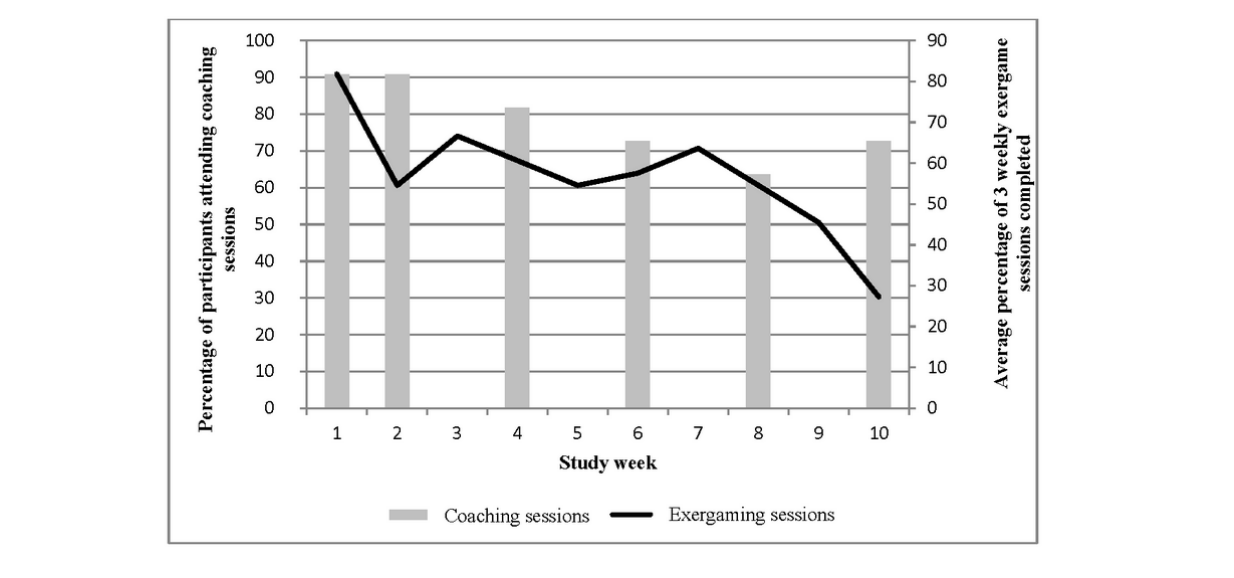
Figure 2. Planned session adherence trends.